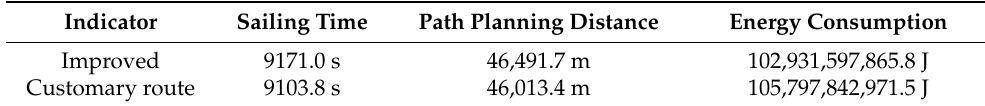
Table 3. Index comparison between improved ant colony algorithm and ship master’s customary route.